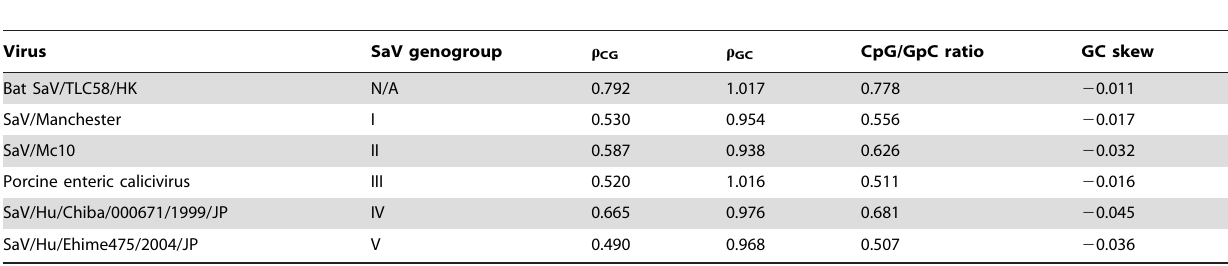
Table 4. CpG dinucleotide bias in selected SaV genomes, as assessed by the odds ratio of CpG ( r CG ) and other measures.